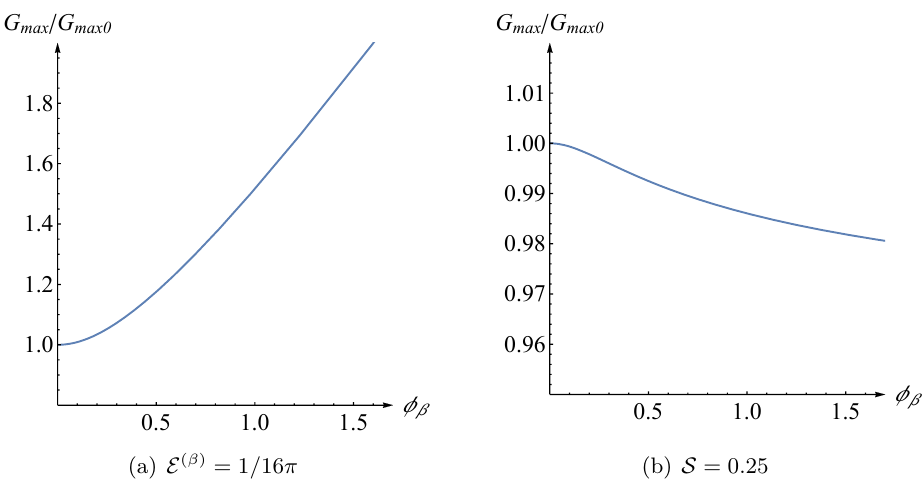
Figure 12 . For ‘ AdS = 1 , relationship between growth rate and φ β . Fixed the E ( β ) = 1 / 16 π , S = 0 . 25 respectively, the larger the parameter φ β , the smaller the maximum value of the growth rate function G ( r )